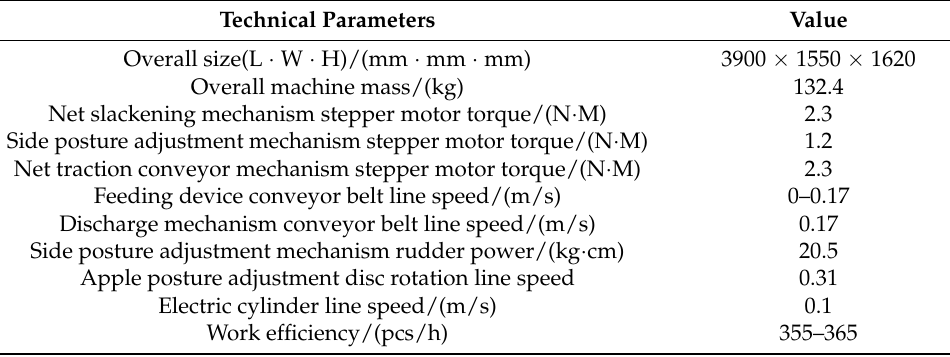
Figure 2. Three-dimensional model of apple foam net sleeve packing machine. Table 1. Technical parameters of the proposed device.